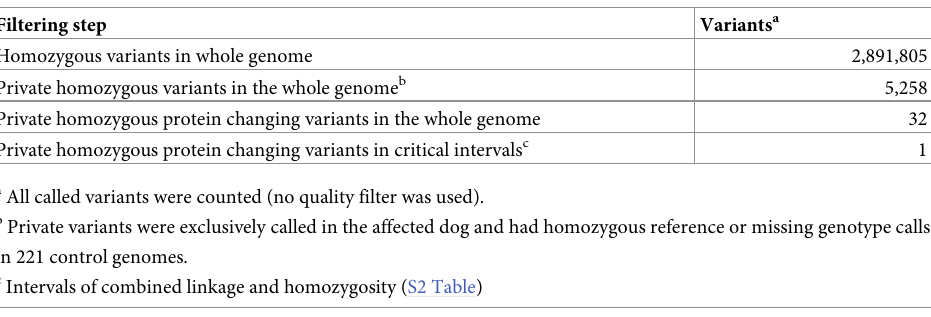
Table 1. Variants detected by whole genome resequencing of an affected Standard